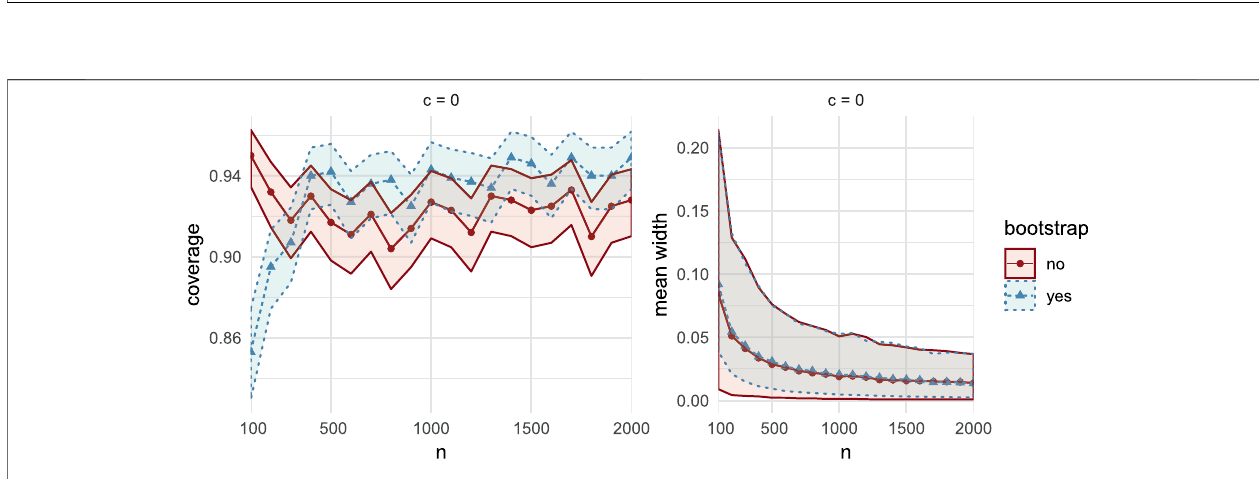
FIGURE 4 | Comparisons of coverage (left column) and mean width (right column) between bootstrap CIs (dashed lines with triangular markers) and the asymptotic CIs (solid lines with circular markers) in MC Study C, for correlation c (cid:2) 0. The horizontal axes display the sample sizes n (cid:2) 5 , 10 , ... , 50.